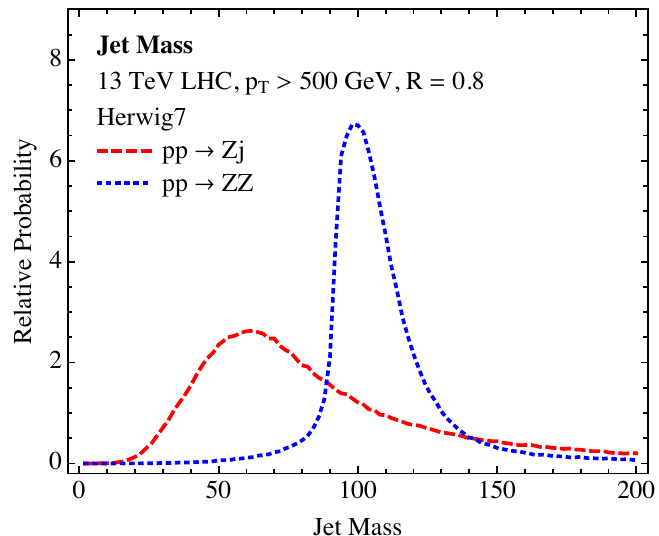
Figure 8. Distribution of the mass of the jet in pp Zj (red dashed) and hadronically-decaying ! Z boson in pp ZZ (blue dotted) from the Herwig parton shower. The minimum transverse ! momentum is 500 GeV, and the jets are found with the anti- k T algorithm with radius R = 0 : 8. In (cid:12)gures 8 and 9, we show validation plots on the jets showered with Herwig, to be compared with (cid:12)gures 3 and 4 from Pythia. The jet mass distribution in (cid:12)gure 8